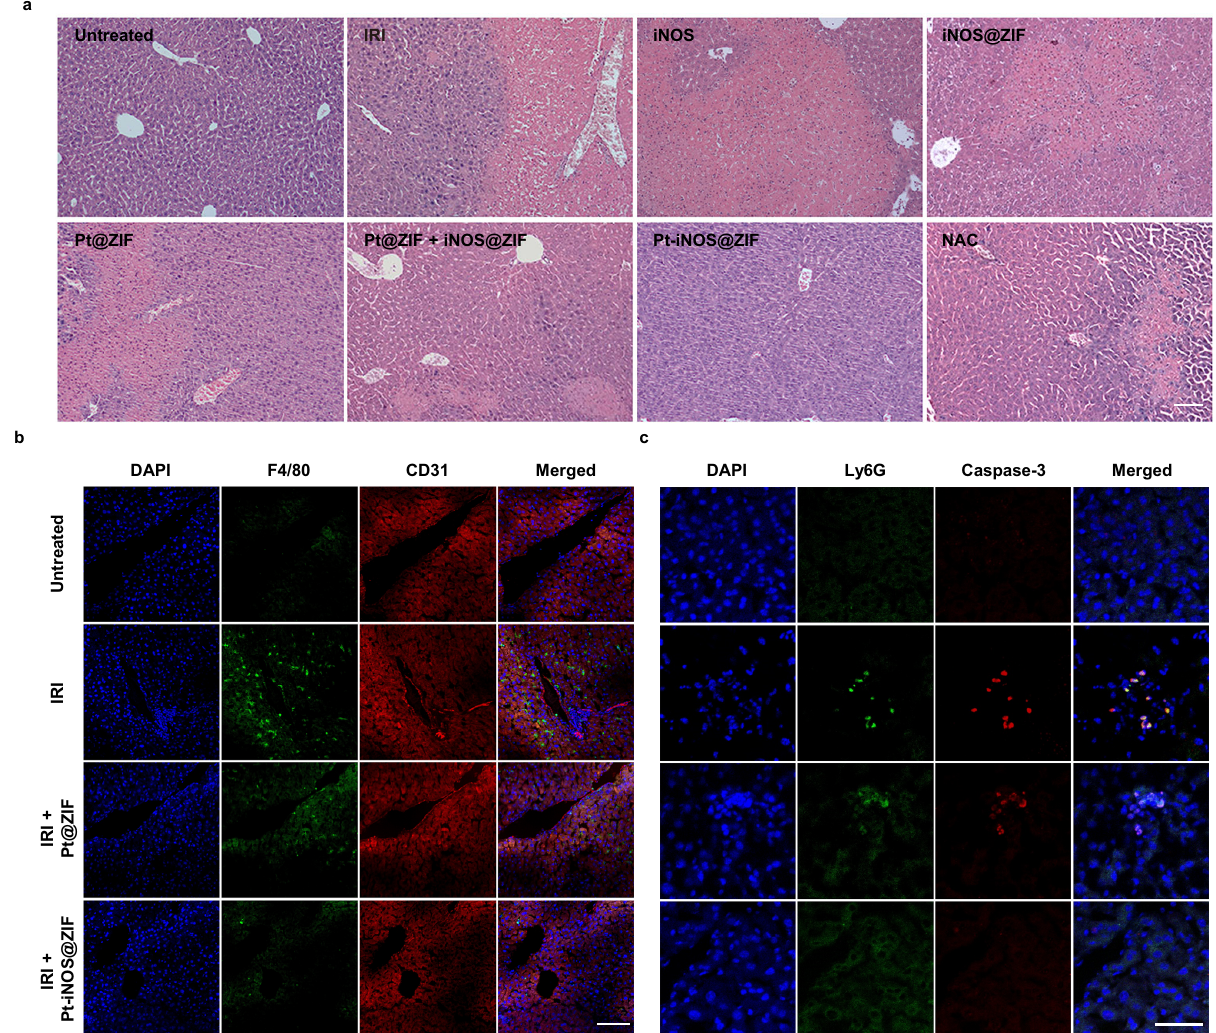
Fig. 6 H&E and Immuno fl uorescence staining on liver tissues. a H&E staining of liver tissues from each group (Untreated, PBS, iNOS, iNOS@ZIF, Pt@ZIF, Pt@ZIF + iNOS@ZIF, Pt-iNOS@ZIF, NAC) after 60 min of ischemia and 12 h of reperfusion. Scale bar: 100 µ m. b Immuno fl uorescence staining of liver tissues with various treatments by using DAPI (blue) for nuclear staining, anti-F4/80 antibody (green) as monocyte/macrophage marker, and anti-CD31 antibody (red) as an endothelial marker from each group. Scale bar: 100 µ m. c Enlarged images of immuno fl uorescence staining with various treatments by using DAPI (blue) for nuclear staining, anti-Ly6G antibody (green) as neutrophil marker and anti-caspase-3 antibody (red) as a cell apoptosis marker. Experiments were performed three times ( a – c ) with similar results. Scale bar: 50 µ